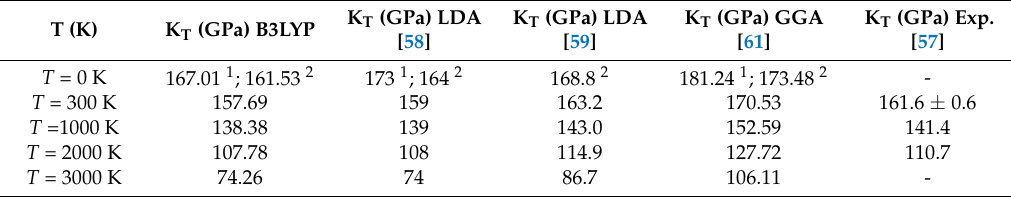
Table 1. Ab initio B3LYP isothermal bulk modulus (K T ) of MgO. Values obtained in this work are compared to experiments [57] and other ab initio simulations at LDA [58,59] and GGA [61] level of theory.